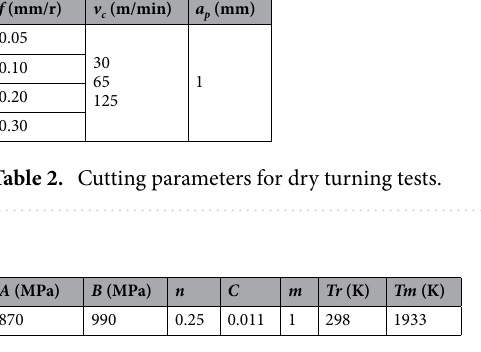
Table 3. JC model parameters for